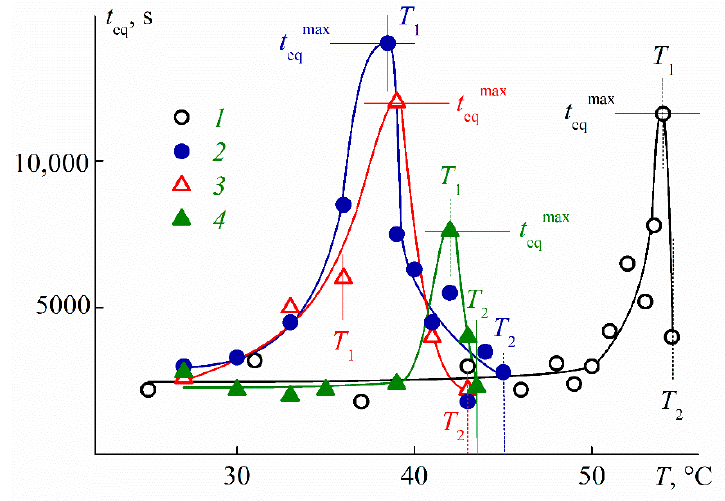
Figure 12. Dependences of time t eq on temperature T for aqueous solutions of C8A-PEtOx (1) at concentration c = 0.0110 g·cm − 3 , C8A-(PiPrOx-b-PEtOx) (2) at c = 0.0120 g·cm − 3 , C8A-(PEtOx-b- PiPrOx) (3) at c = 0.0111 g·cm − 3 , and C8A-P(EtOx-grad-iPrOx) (4) at c = 0.0117 g·cm − 3 .